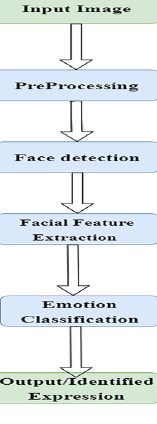
Fig. 1. Problem formulation